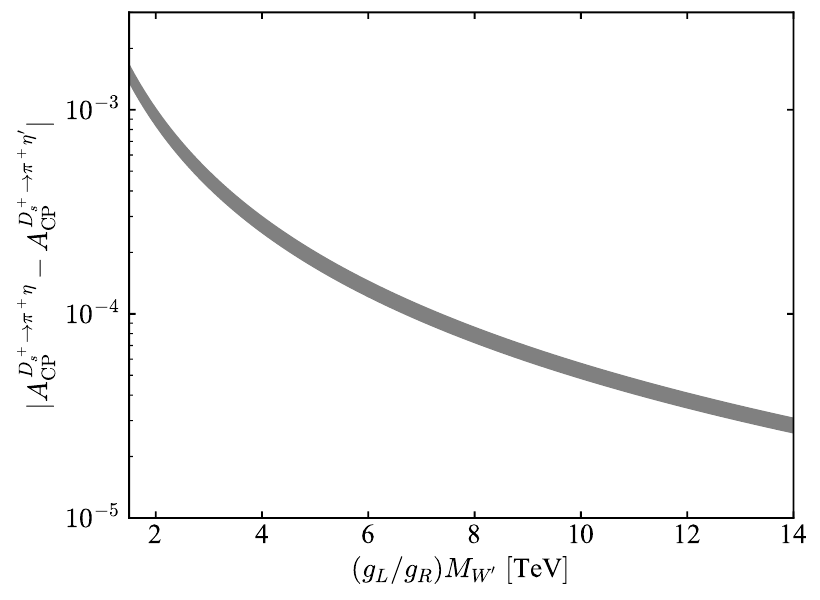
! (cid:25) + (cid:17) and D + ! (cid:25) + (cid:17) 0 in the SU(2) L (cid:2) s s